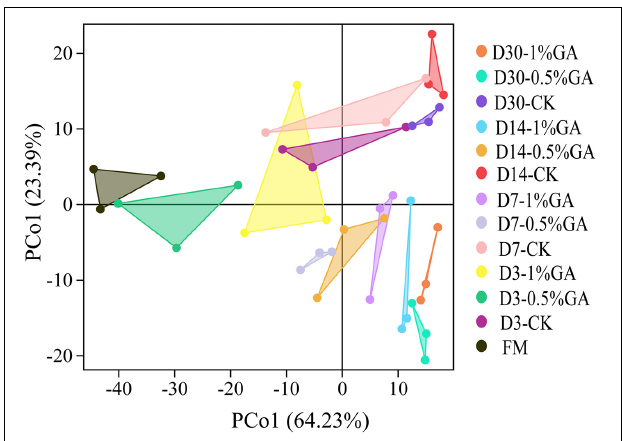
FIGURE 1 | Principal component analysis (PCA) of bacterial communities for whole plant soybean silage with and without the addition of gallic acid (GA) (FM, fresh matter; CK, blank control; 0.5% GA, 0.5% FM GA addition; 1% GA, 1% FM GA addition).